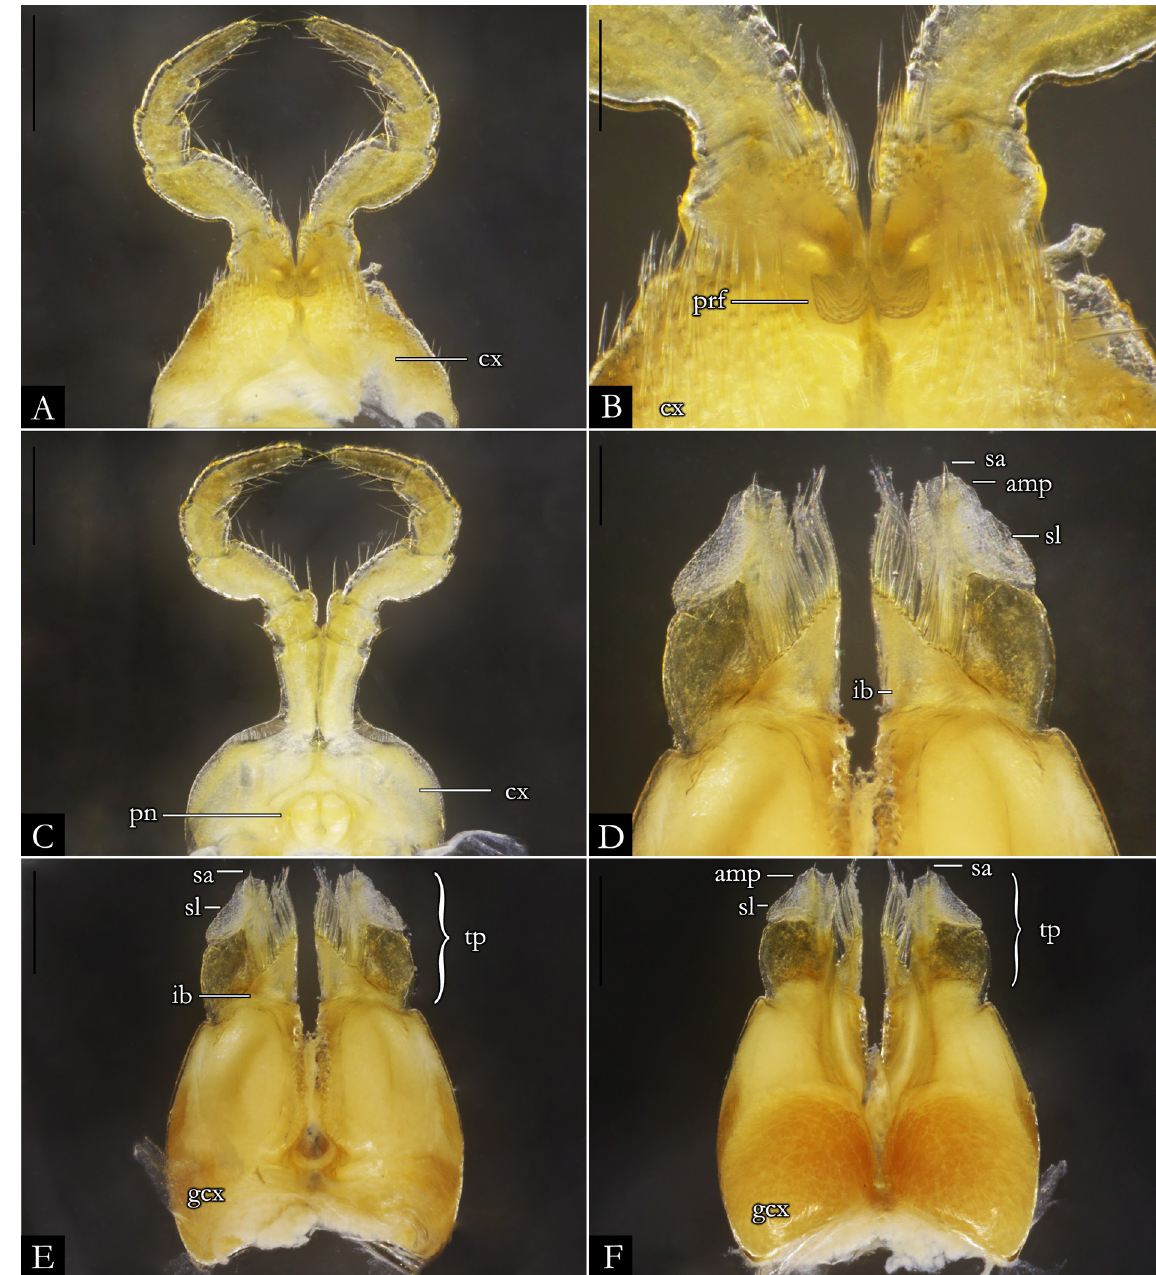
Fig. 94. Pseudonannolene mesai Fontanetti, 2000, ♂ (IBSP 1888). A . First leg-pair. B . Detail of prefemur. C . Second leg-pair. D . Detail of telopodites, in anal view. E . Gonopods, in anal view. F . Gonopods, in oral view. Abbreviations: see Material and methods. Scale bars: A, C, E–F = 0.5 mm; B, D = 0.2